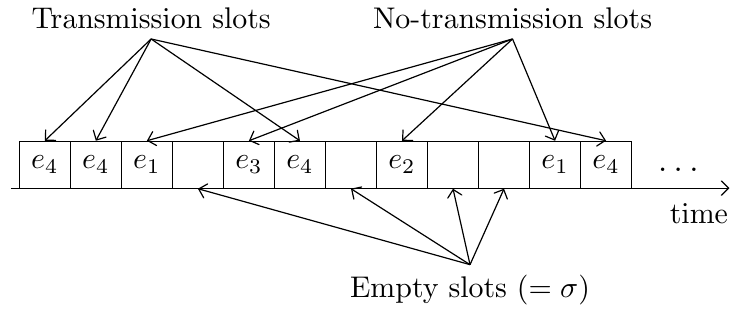
Figure 6. Classification of the system slots in